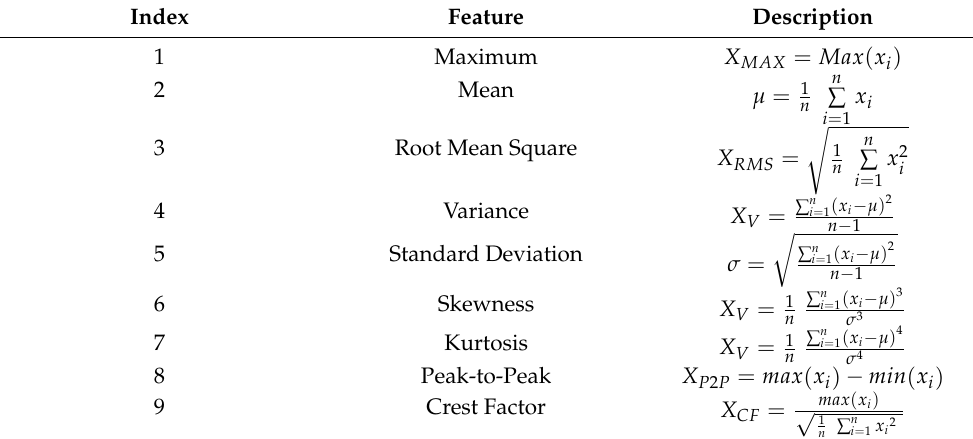
Table 2. Time-domain features for commonly observed sensor signals for machining according to